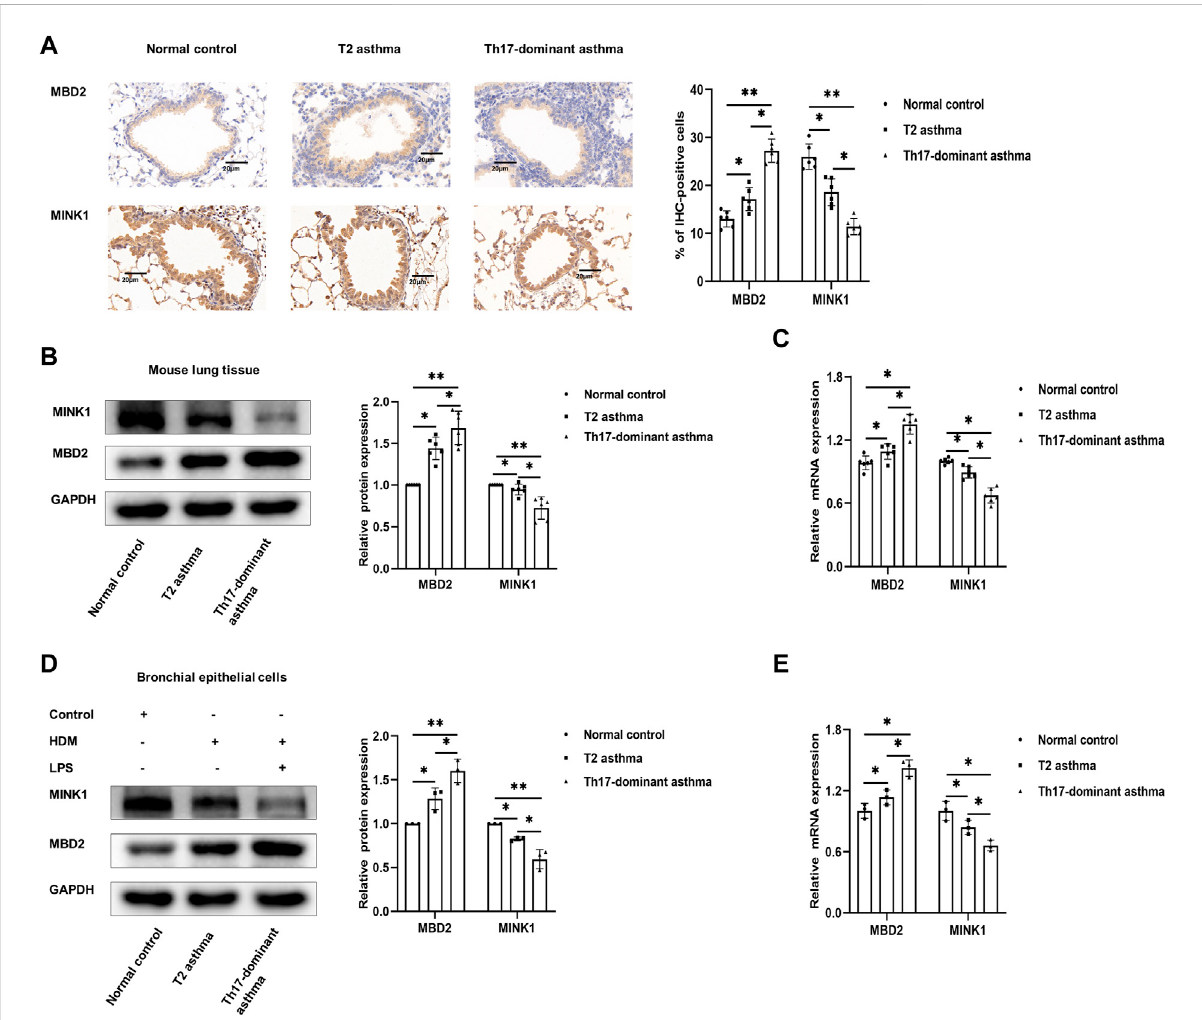
FIGURE 3 ExpressionofMBD2andMINK1inTh17-dominantasthma (A) Lungtissuesofeachgroupwerestainedforanti-MINK1andanti-MBD2.Scalebar, 20 µm. (BandC) TheexpressionofMINK1andMBD2proteinandmRNAinlungtissuesofeachgroupwasdetectedbywesternblotandqRT-PCR. (D and E) The expression of MINK1 and MBD2 protein and mRNA in BECs of each group was detected by western blot and qRT-PCR. * p < 0.05. ** p < 0.01. IHC,